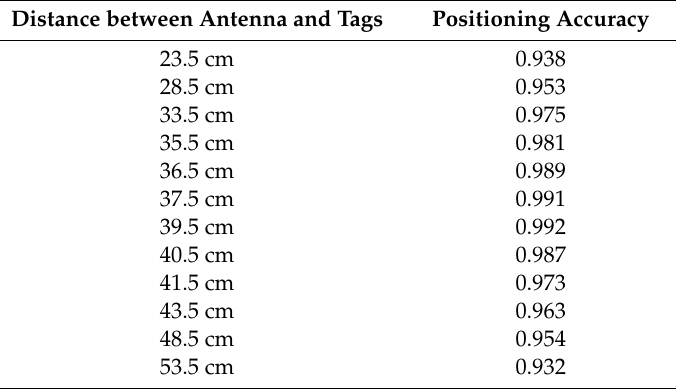
Table 3. Distance between the antenna and tags.